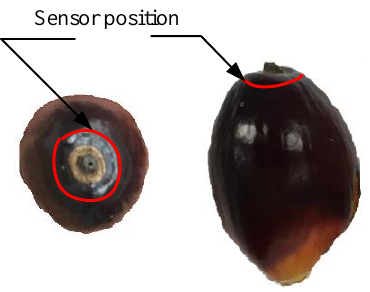
Figure 6. Electrode sensor position on the fruit surface.